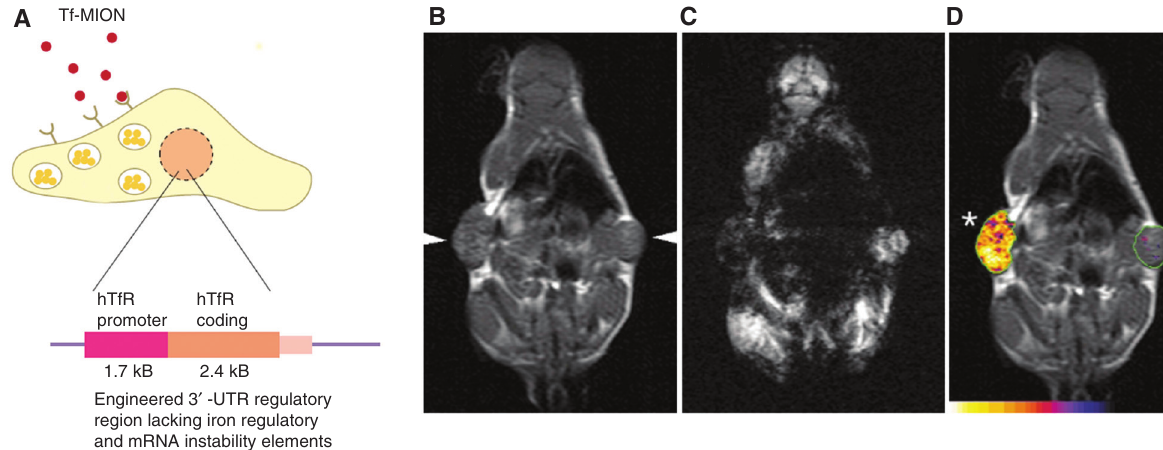
Figure 2 Transgene expression in live animal by MR imaging. (A) Overexpression of engineered transferrin receptor (ETR) expression results in more cell uptake of the Tf-MION probe per hour than in control cells. The ETR cDNA sequence consists of the hTfR promoter, the coding sequence and the engineered 3 untranslated region (UTR) regulatory sequence. (B) In vivo MR imaging of a single mouse with stably expressing ETR (ETR + , left arrowheads) and nontransfected (ETR - , right arrowheads) flank tumors. T1-weighted coronal SE image (imaging time, 3.5 min; voxel resolution, 300 × 300 × 3000 μ m). ETR - and ETR + tumors have similar signal intensities. (C) T2-weighted gradient-echo image corresponding to the image in (A), showing substantial differences between ETR - and ETR + tumors (imaging time, 8 min; voxel resolu- tion, 300 × 300 × 3000 μ m). As expected, ETR-mediated cellular accumulation of the superparamagnetic probe decreases signal intensity. These differences in MR signal intensity were most pronounced using T2- and T2*-weighted imaging pulse sequences, consistent with the increased transverse relaxation rate (R2) after cellular internalization. (D) Composite image of a T1-weighted spin-echo image obtained for anatomic detail with superimposed R2 changes after Tf-MION administration, as a color map. *Difference in R2 changes between the ETR + and ETR - tumors. Scale bar (bottom left) represents 10 mm, n = 1. (Reproduced with permission from Ref. [41], Copyright Nature Publishing Group,